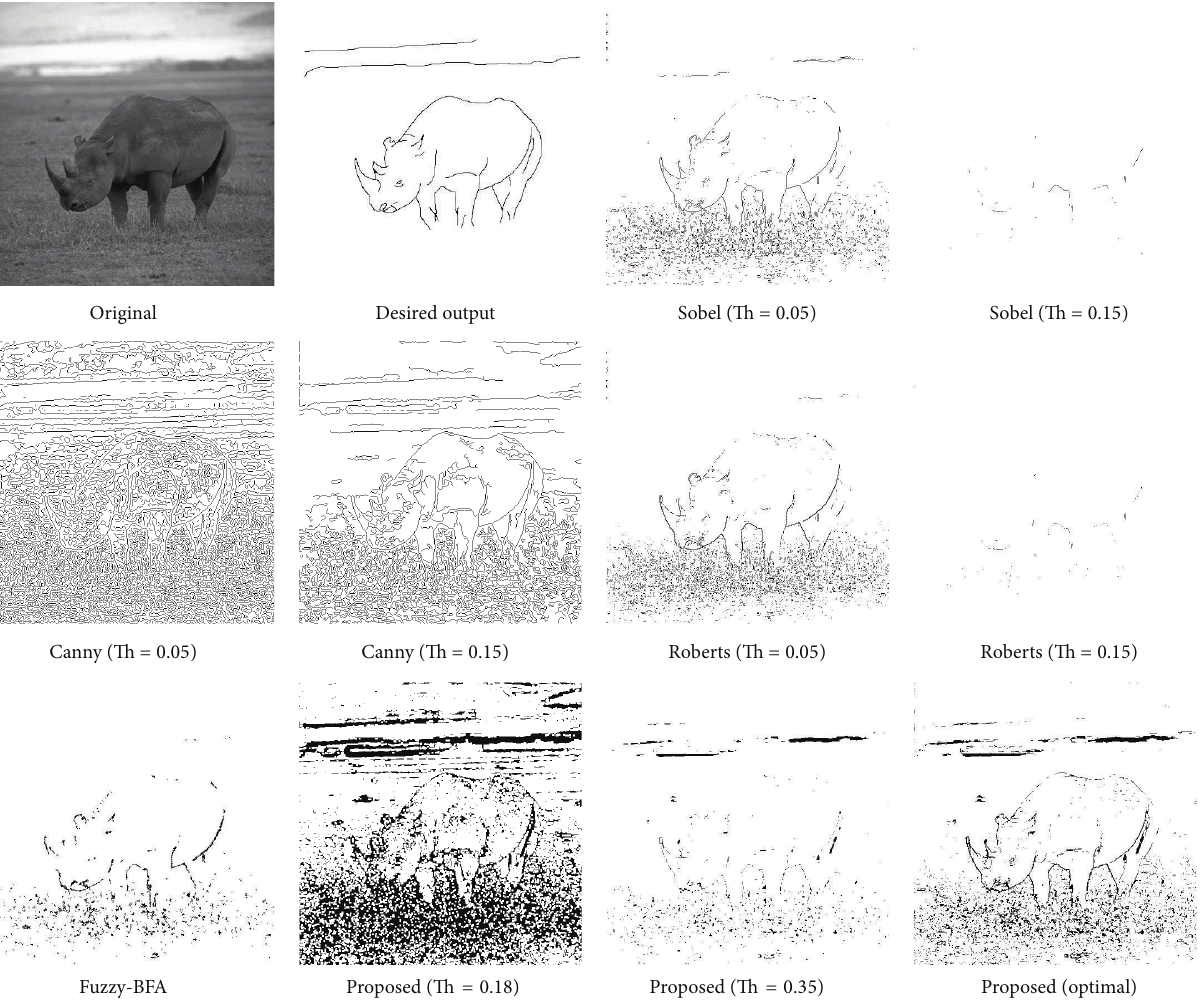
Figure 8: Edge detection results of “rhino” image: desired edge output of “rhino” image; Sobel, Canny’s, and Roberts methods using thresholds = 0.05 and 0.15; fuzzy-BFA method; proposed method with fixed thresholds (0.18 and 0.35) and optimal threshold.